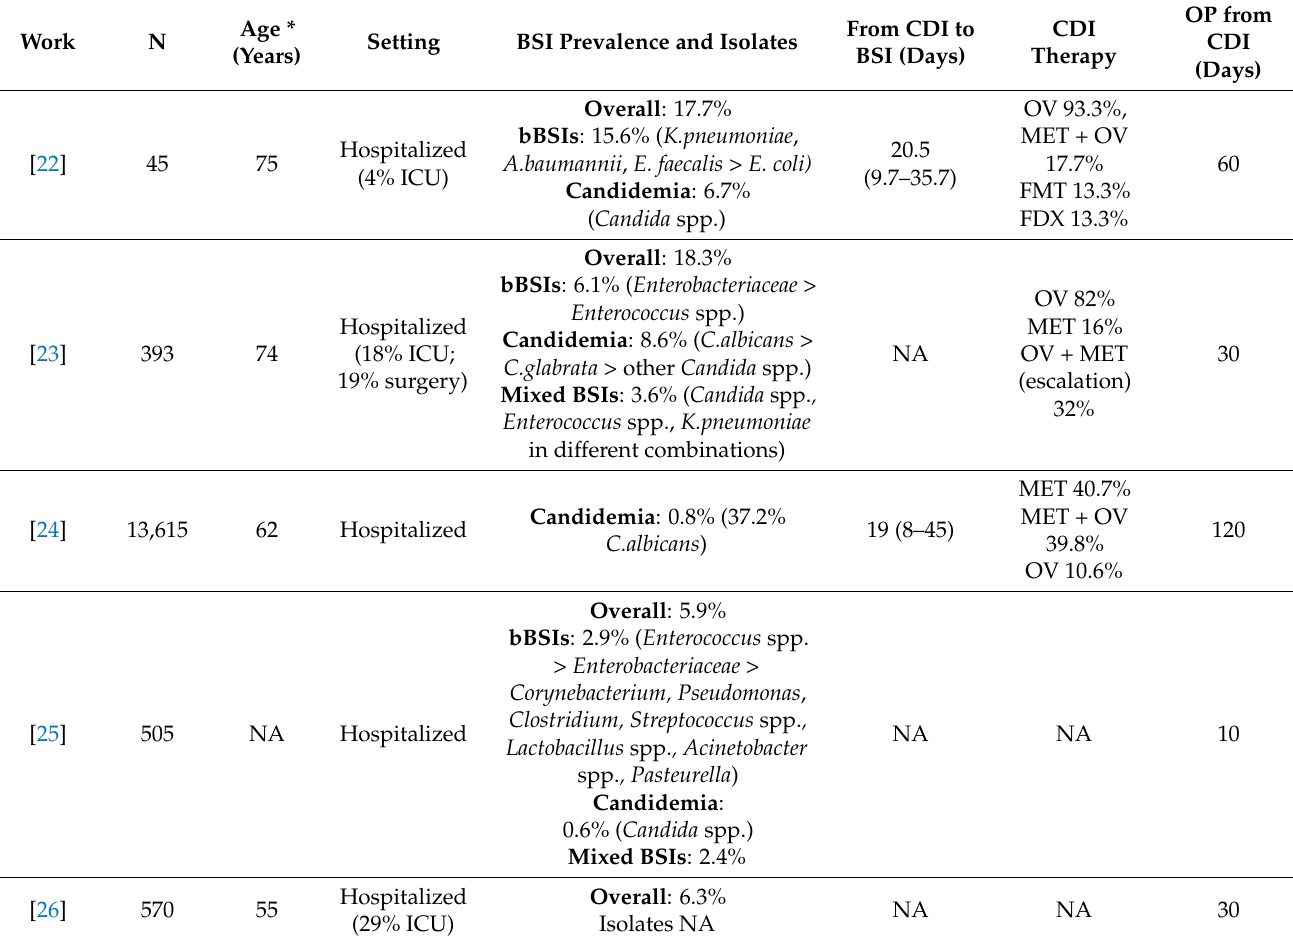
Table 1. Summary of literature studies reporting period prevalence data on bacterial and/or fungal blood-stream infection during and following Clostridioides difficile